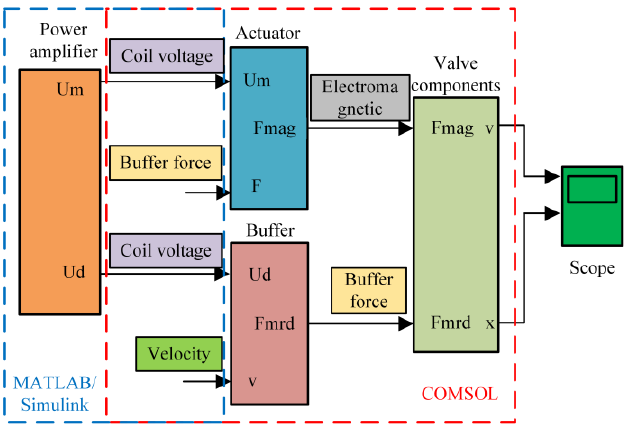
Figure 15. Co-simulation model of EMVV system.